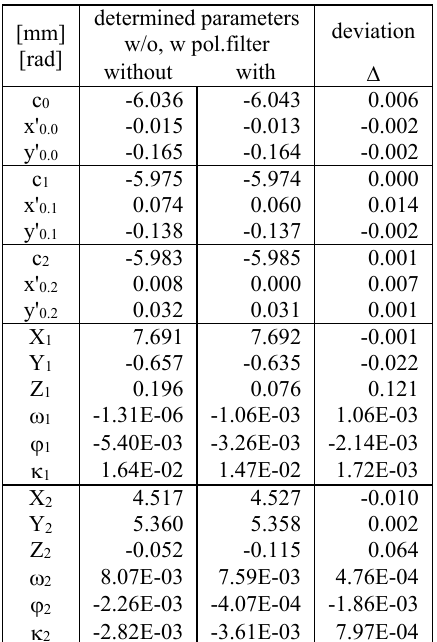
Figure 9. Radial-symmetric lens distortion curves of miniature cameras with and without polarising filter. Figure 8. Trinocular miniature camera system (a) and system setup with light source and filter (b); direction of The results for the interior orientation show a similar but weaker polarisation is indicated as blue and red lines, angle trend in parameters as in the Nikon D4 test. In comparison to the of polarisation  is 90° (example cross-polarisation). camera size, the deviations are still in a similar range of values. The principal distances are slightly longer (6 µm) or do not change significantly with polarising filter. The principal points are slightly shifted (0.7 - 4.0 px) to the image centres. The radial- symmetric lens distortion is relatively low. Hence, the influence of the polarising filter is mainly less than 0.2 px (Figure 9). The results for the relative orientations of the right and top camera to the left show larger changes in Z direction than in XY direction. The projection centres of the right and top camera are located approximately 0.1 mm farther from the object than the left camera. Due to correlations between the Z direction and the principal distance, the shift in Z position may also be caused by refraction of the filter. The shift in XY position may be caused by a tilt between the filter and image